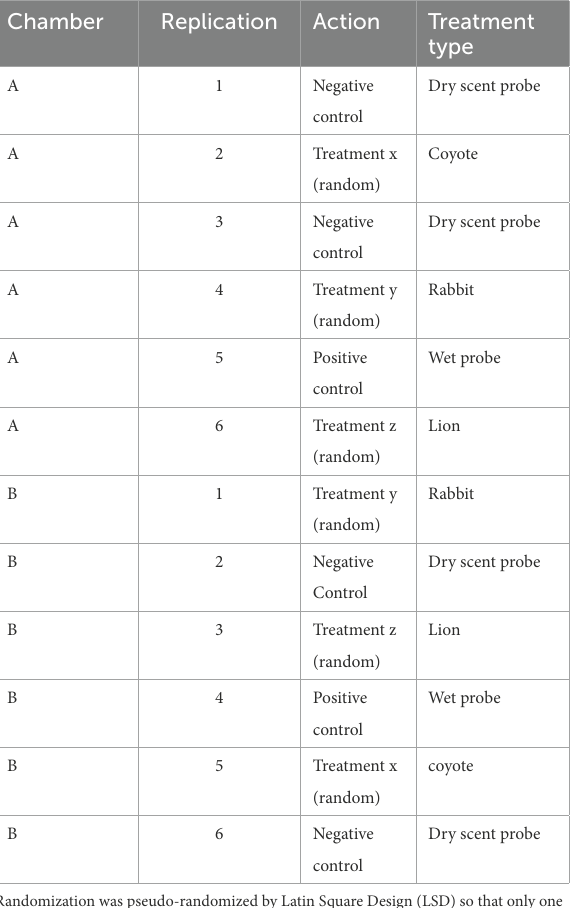
Table 1 Each block below was repeated three times.